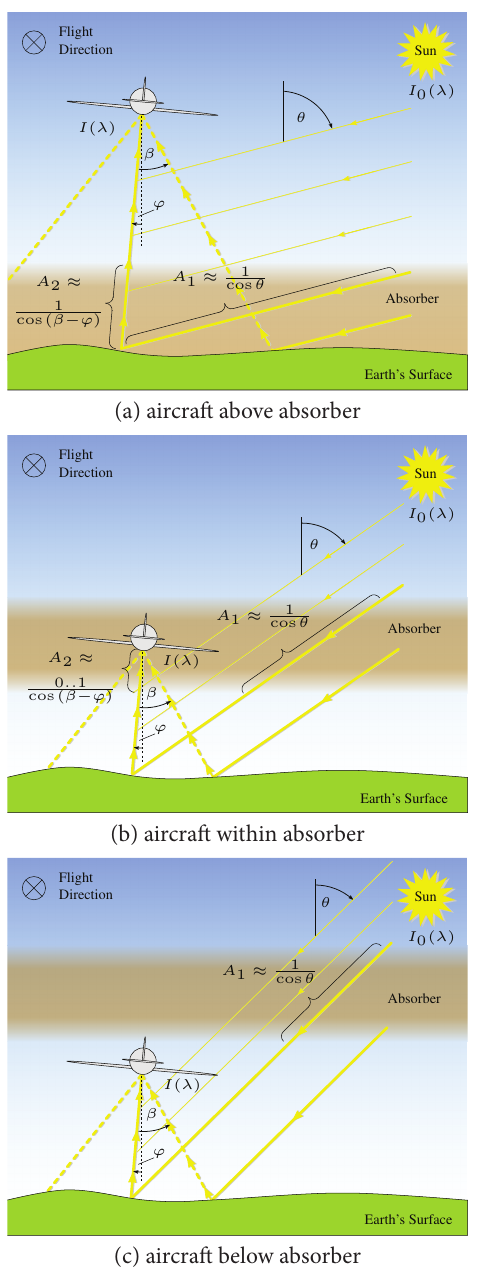
Figure 14. Simple geometric approximation of the optical light path for the nadir scanner. Due to clear sky conditions and low flight altitudes ( ∼ 1500m) most of the collected light is scattered on the ground. The length of the optical light path inside the absorber is determined by the factors A 1 and A 2